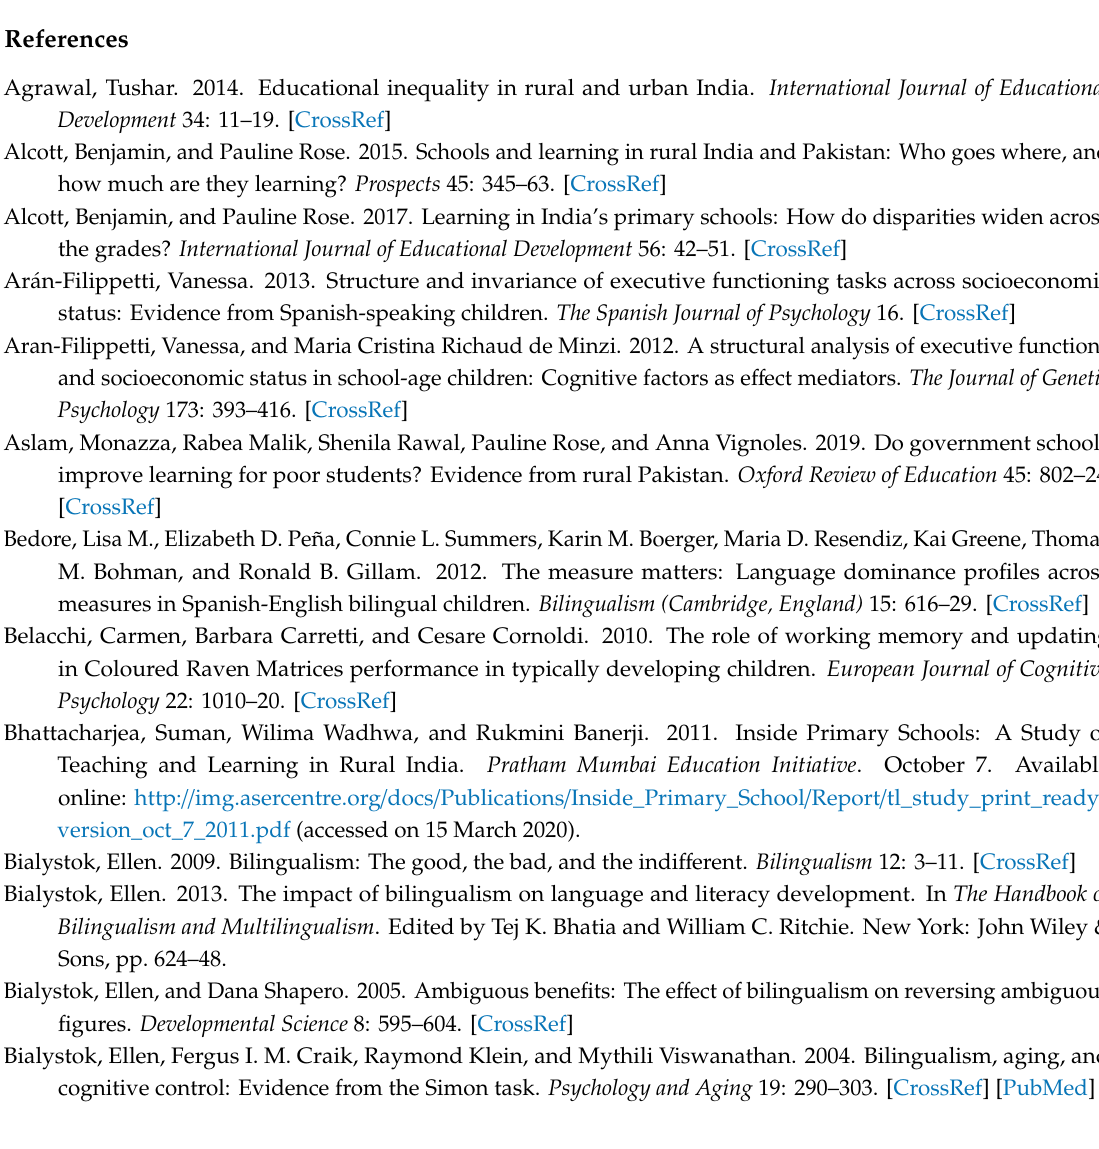
Figure A1. Distribution of the scores on sociolinguistic diversity ( left graph) and socio-economic status (SES; right graph) for children from Delhi and Hyderabad. Purple areas reflect the overlap between the children from the two cities on the on the sociolinguistic diversity and SES scores.